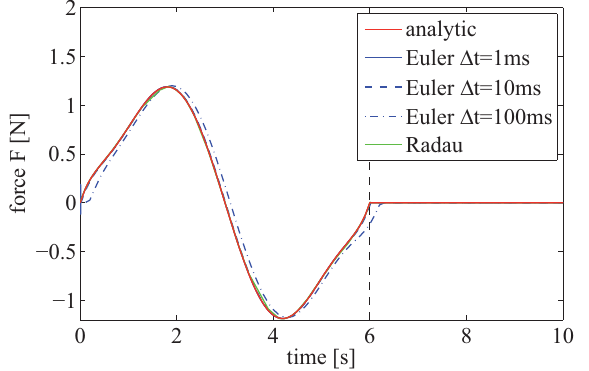
Figure 10. Mass on car – case 4, flat system: computed control input u d .